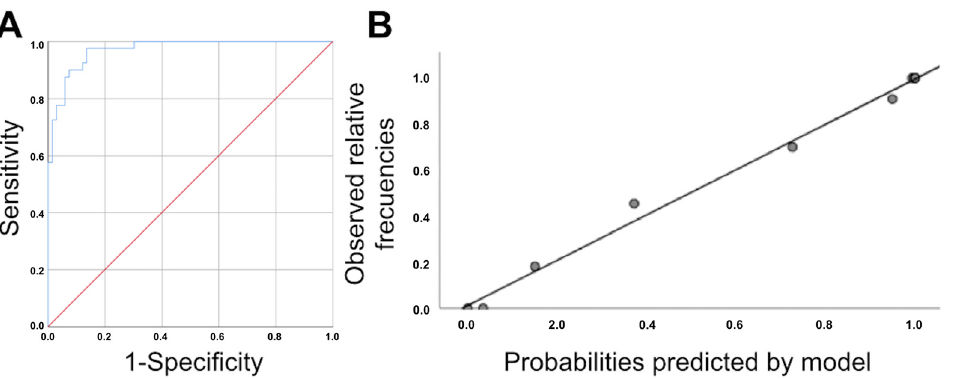
Figure 3. ( A ): ROC curve for the logistic regression model obtained for the association between the difference in the pubis–uterine fundus distance at rest and with the Valsalva maneuver, age, avulsion and ballooning. Area under the ROC curve: 0.971 (95% CI, 0.945–0.997; p < 0.0005) ( B ): Calibration graph of the original logistic regression model obtained from the association between the difference in the pubis–uterine fundus distance at rest and with the Valsalva maneuver, age, avulsion and ballooning. Table 3. Evaluation of the models.